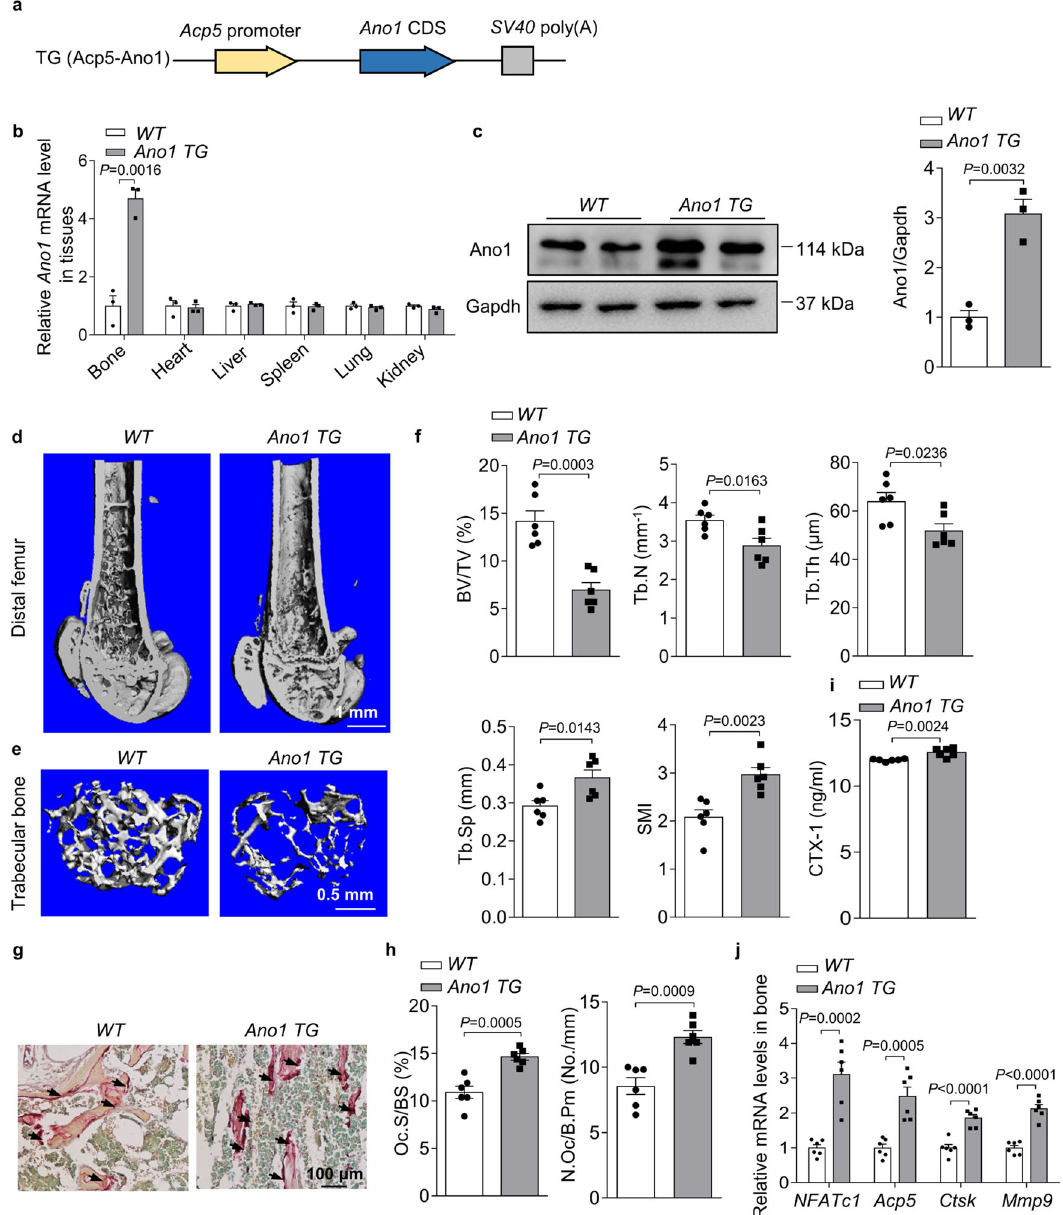
Fig. 3 Ano1 overexpression decreases bone mass. a Schematic representation of the transgenic construct used to generate Ano1 transgenic mouse lines. b QRT-PCR analysis of Ano1 mRNA level in bone and other tissues from 6-month-old WT and osteoclast-speci fi c Ano1 over expression ( Ano1 TG ) mice ( n = 3). Ano1 mRNA level in all tissues was normalized to WT mice. c Western blot analysis of Ano1 protein level in bone tissues from WT and Ano1 TG mice mice (left). The quanti fi cation of Ano1 protein level in bone from two groups (right) ( n = 3). d Representative images showing three-dimensional distal femurs by micro-CT reconstruction from WT and Ano1 TG female mice at 6 months old. Scale bar, 1 mm. e Representative images showing three- dimensional trabecular architecture by micro-CT reconstruction at the distal femurs from WT and Ano1 TG mice at 6 months old. Representative images of six independent tissue in each group. Scale bar, 0.5 mm. f Micro-CT measurements for BV/TV, Tb.N, Tb.Th, Tb.Sp, and SMI at the distal femurs from WT and Ano1 TG mice ( n = 6). g Representative images of TRAP staining of the proximal tibia from WT and Ano1 TG mice. Scale bar, 100 μ m. h Histomorphometric analysis of the images for number of osteoclasts per bone perimeter (N.Oc/B.Pm) and osteoclast surface per bone surface (Oc.S/ BS) ( n = 6). i ELISA analysis of CTX-1 protein levels in the serum from WT and Ano1 TG mice ( n = 6). j QRT-PCR analysis of NFATc1, Acp5, Ctsk , and Mmp9 mRNA levels in bone tissues from WT and Ano1 TG mice ( n = 6). All data are the mean ± s.e.m. Statistical analysis for comparison of two groups was performed using two-tailed unpaired Student ’ s t -test. Source data are provided as a Source Data fi prompted us to test whether there existed interaction between RANKL-treated osteoclasts but do not interact in the absence Ano1 and RANK. Immuno fl uorescence results show that Ano1 is of RANKL stimulation (Fig. 5f). Interestingly, benzbromarone, an co-localized with RANK at the plasma membrane of osteoclasts Ano1 inhibitor, obviously attenuated their interaction (Fig. 5g). induced by RANKL (Fig. 5e). The coimmunoprecipitation We also found that the interaction between Ano1 and RANK was demonstrated that RANK and Ano1 interact strongly in attenuated when E702Q and E705Q mutations were introduced